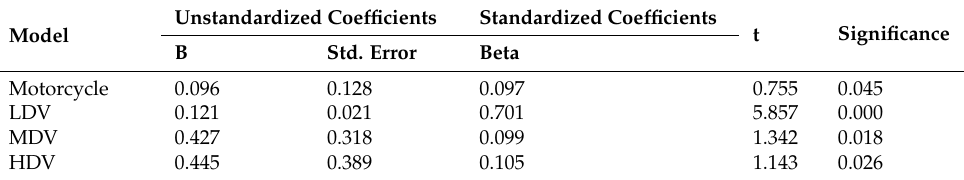
Model Table 4. Hybrid emission factors for different vehicle classes by multiple regression (g/km).